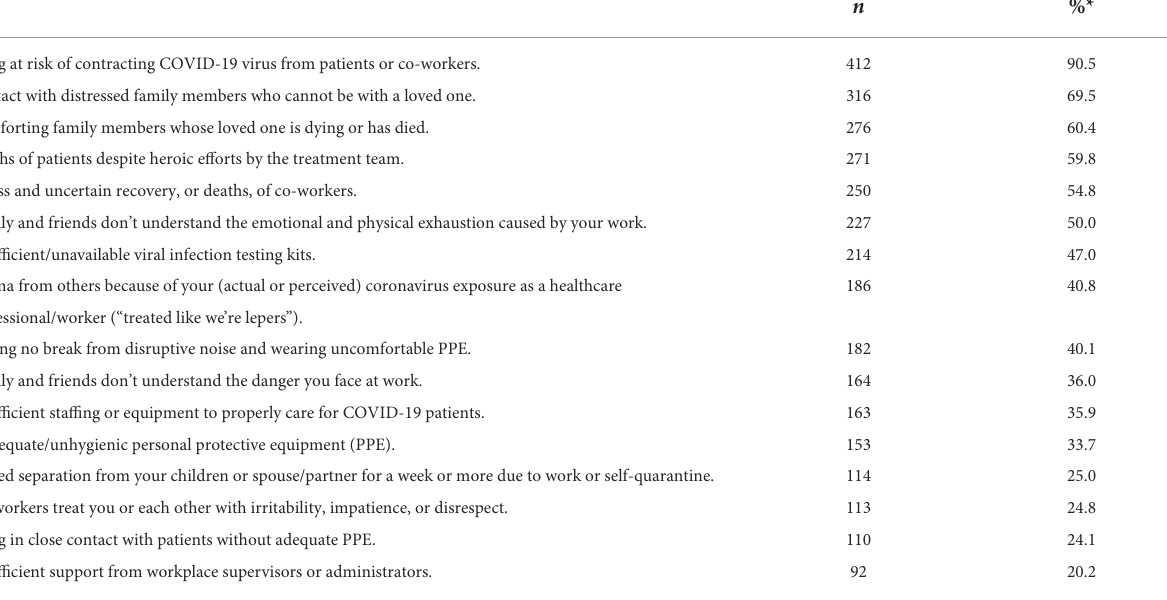
TABLE 2 Participant endorsement of EPII SHMb items